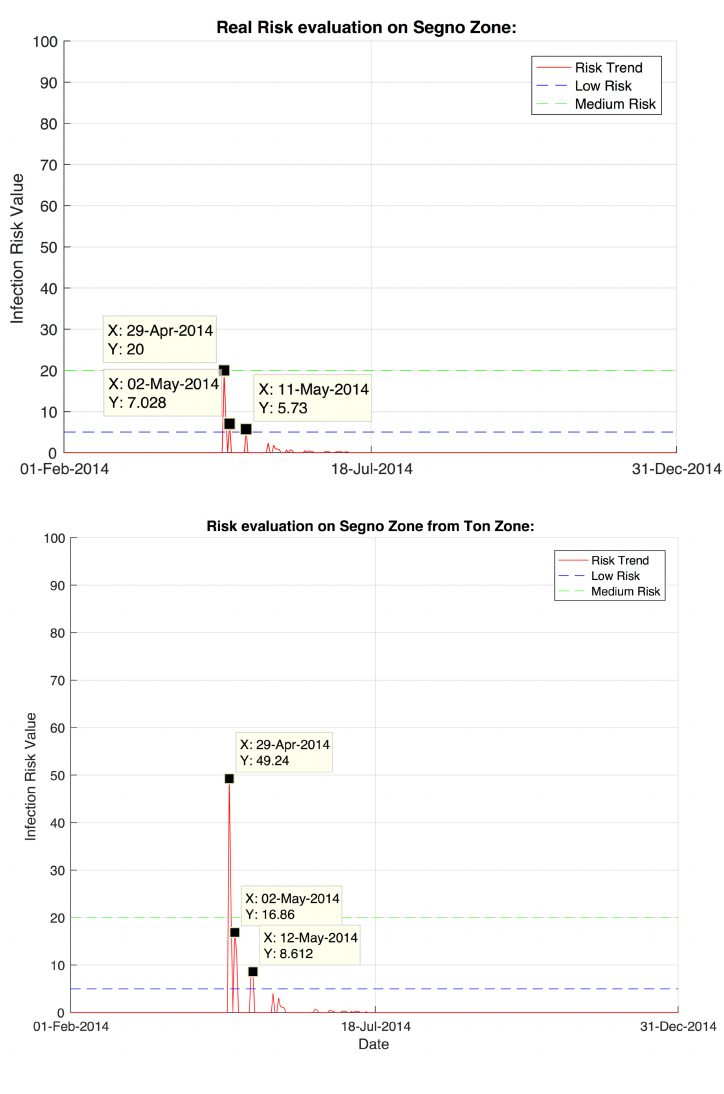
Figure 12. Risk evaluation comparison for Example 2: on top, risk evaluation for Segno’s zone using weather data of its own weather station; at the bottom, risk evaluation for Segno’s zone using weather data of Ton’s weather